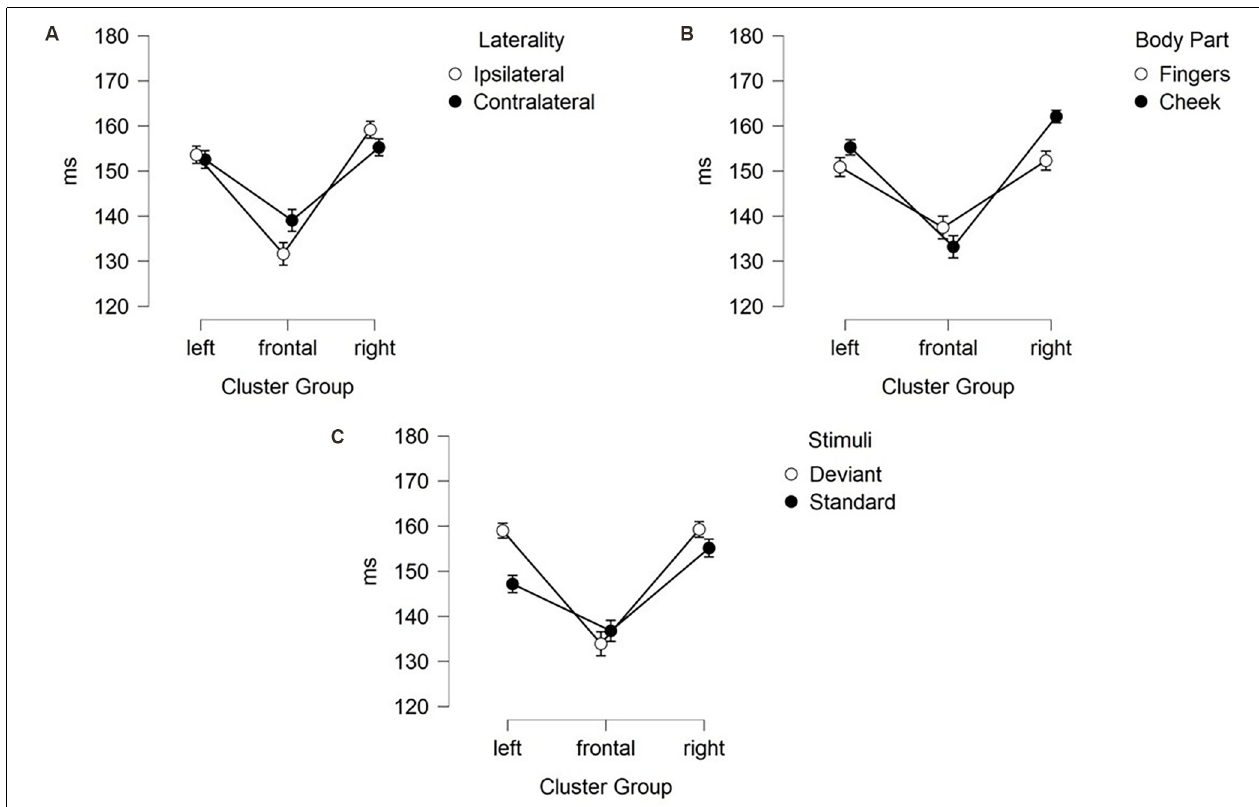
FIGURE 5 | Mean values (ms) of N140 latencies with SE. Two-way-interactions: (A) Cluster Group x Laterality, (B) Cluster Group x Body Part, and (C) Cluster Group x